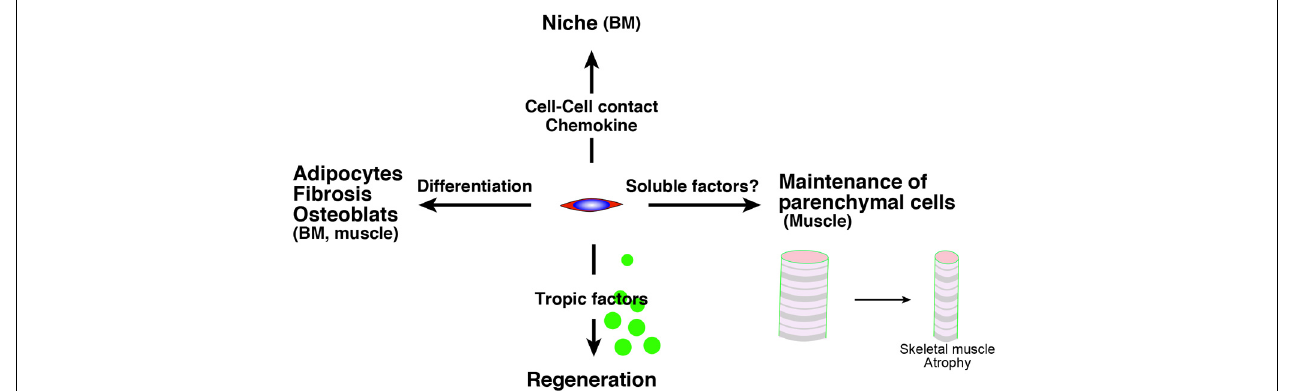
FIGURE 1 | The roles of mesenchymal progenitors. Mesenchymal progenitors have as least four aspects. (1) The differentiative potential into adipocytes, fibrosis-related cells, osteoblast, which are observed in BM and skeletal muscle. (2) They serve as niche cells in BM through